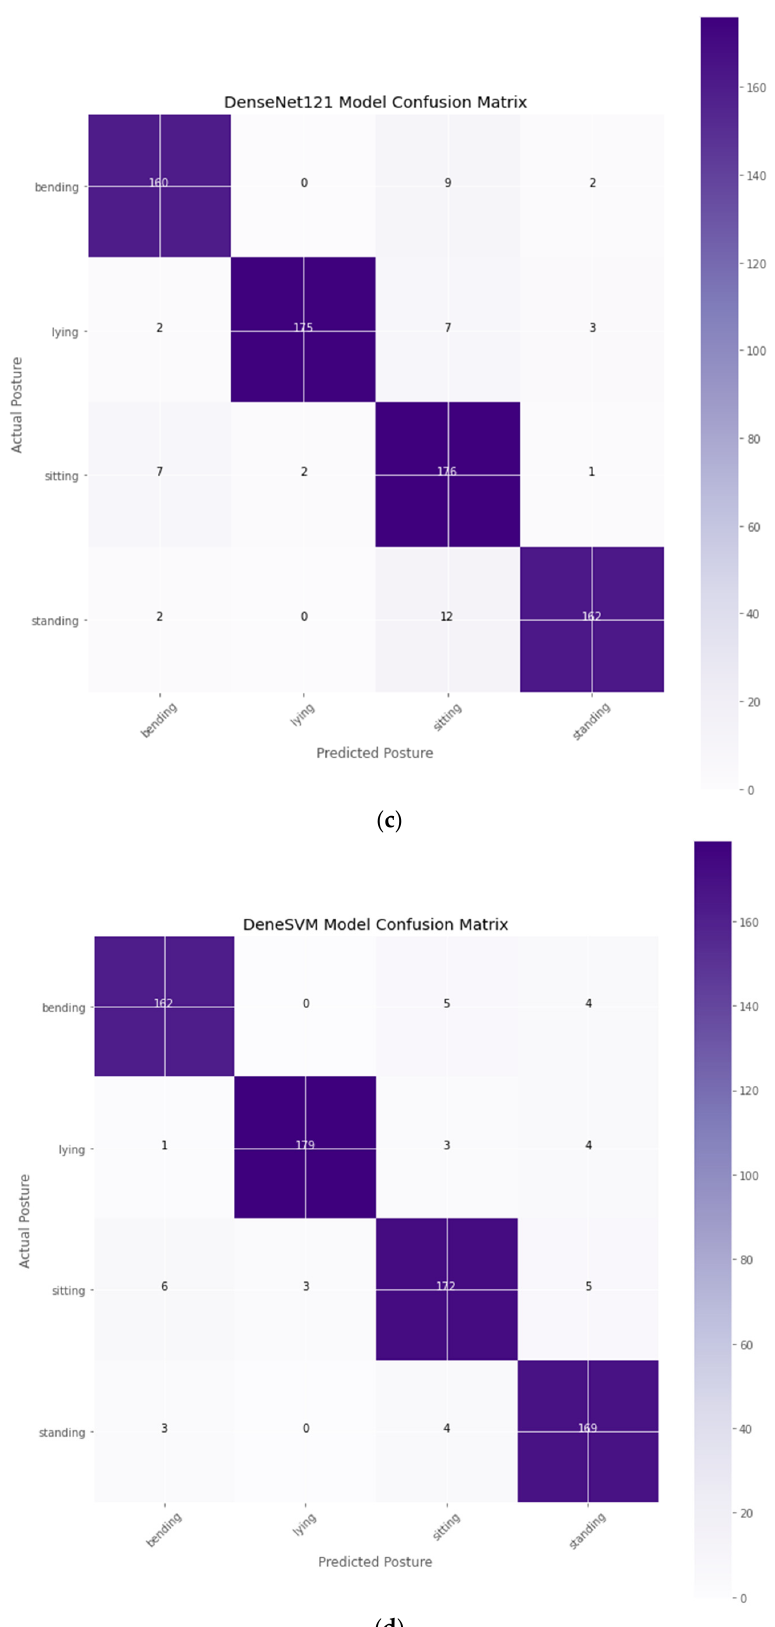
Figure 4. Confusion matrix of DTL models: ( a ) InceptionV3; ( b ) ResNet50V2; ( c ) DenseNet121; and ( d ) Proposed